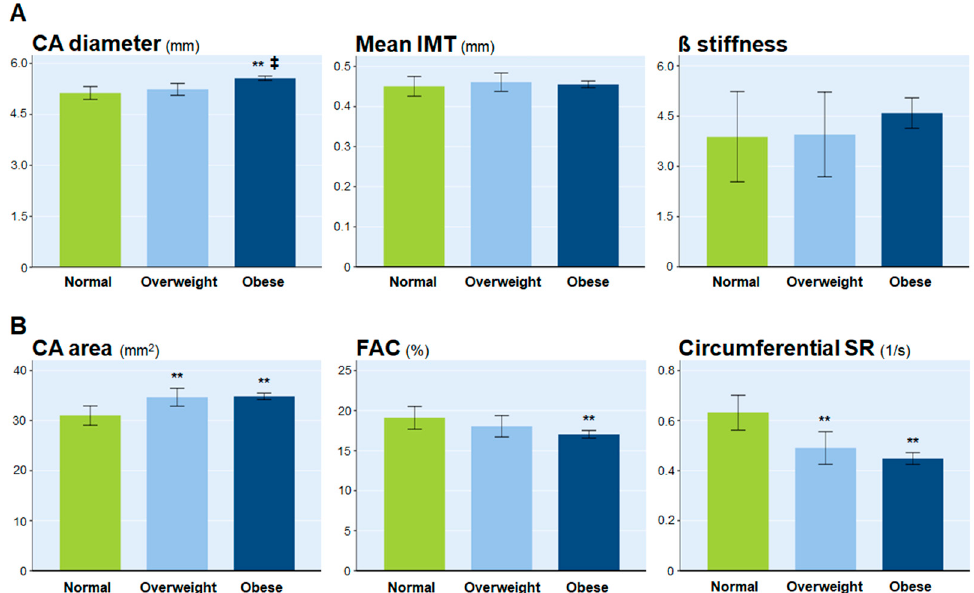
Figure 2. Comparison of M-mode-derived parameters and VVI parameters between the groups after adjusting for covariates including age, sex, height, mean blood pressure, LDL cholesterol and HOMA-IR. ( A ) M-mode-derived parameters; ( B ) VVI parameters. ** vs. normal, <0.01; ‡ vs. overweight < 0.01. CA, carotid artery; IMT, intima–media thickness; FAC, fractional area change; SR, strain rate; VVI, velocity vector imaging.